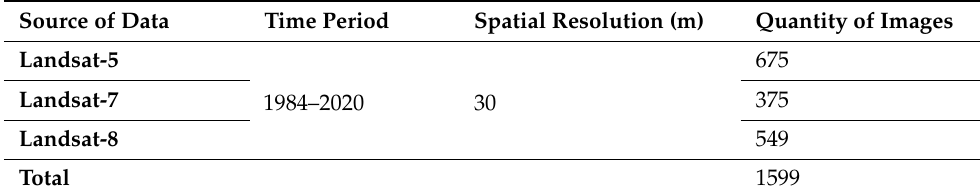
Table 1. Remote sensing data used in this study. Source of Data Time Period Spatial Resolution (m) Quantity of